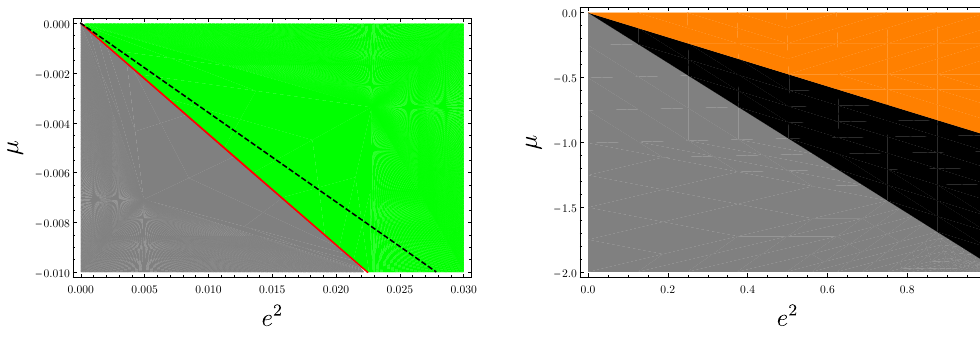
Figure 17 . Phase space of constraints for d = 5. The plot shows the di(cid:11)erent possibilities for critical behaviour in ( (cid:22); e ) parameter space for k = 1 (left) and k = (cid:0) 1 (right). Green regions denote single physical critical points with all physical constraints ful(cid:12)lled. In grey regions there are no possible critical points. The thin red line denotes two potential critical points. In the left plot, the critical points that lie below the dashed black curve possess negative Wald entropy. In the right plot, the black region indicates that the critical pressure exceeds the maximum pressure, while the orange region indicates that the potential critical point corresponds to a negative mass black